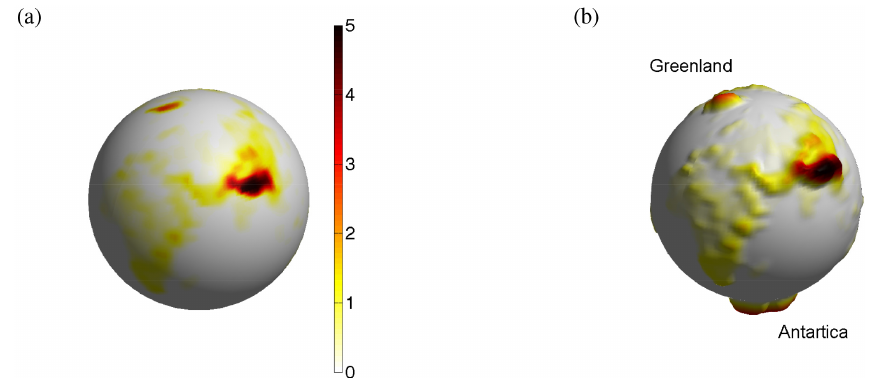
Figure 1. Earth’s topography: (a) actual scale of the problem (the color bar is the grid-averaged altitude above sea level in kilometers). (b) Result of the change of variable (Eq. 16) selecting ξ 0 and ξ b as in Eq. (18), where N H = 18566, N r = 70, h H = h r = 0 . 05 and β = 0 .